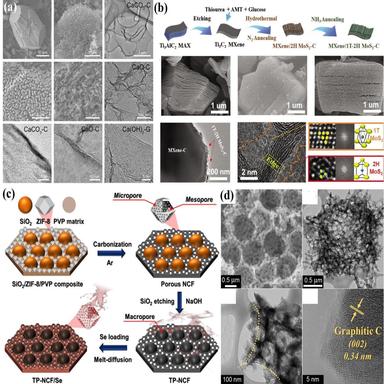
(a) Morphology of as-obtained HPC/HPG materials with different templates: SEM images of commercial CaCO3 nanoparticles and the resultant CaCO3-C, TEM image of CaCO3-C. SEM image of CaCO3-derived CaO nanoparticles and the resultant CaO-C, TEM image of CaO-C, CaCO3-C, CaO-C, and Ca(OH)2-G Copyright 2018,American Chemical Society. (b) Schematic illustration of the fabrication process of MXene/1T-2H MoS2-C composites. SEM images of MXene, MXene/2H MoS2-C, and MXene/1T-2H MoS2-C, TEM and HRTEM ima